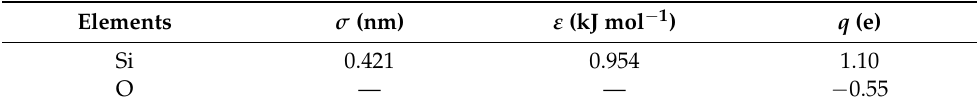
Table 3. Non-bonding interaction parameters of all-silica zeolites.